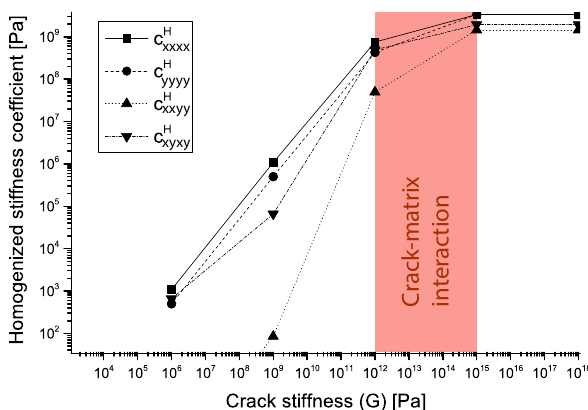
Figure 3. Homogenized stiffness function of crack stiffness. Below the red area crack stiffness is dominant and above porous matrix is dominant. The red area corresponds to a material with both crack and porous matrix contribution to the